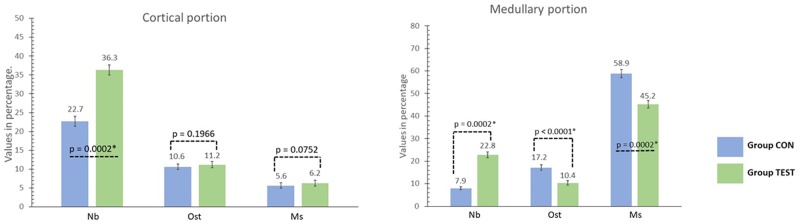
Bar graphs of the morphological parameters analysis of new bone formation (Nb), osteoid matrix (Ost) and medullary spaces (Ms) for both groups and in the two portions analyzed (cortical and medullary) at 4 weeks after the implantations.*statistically significative (P < 0.05).